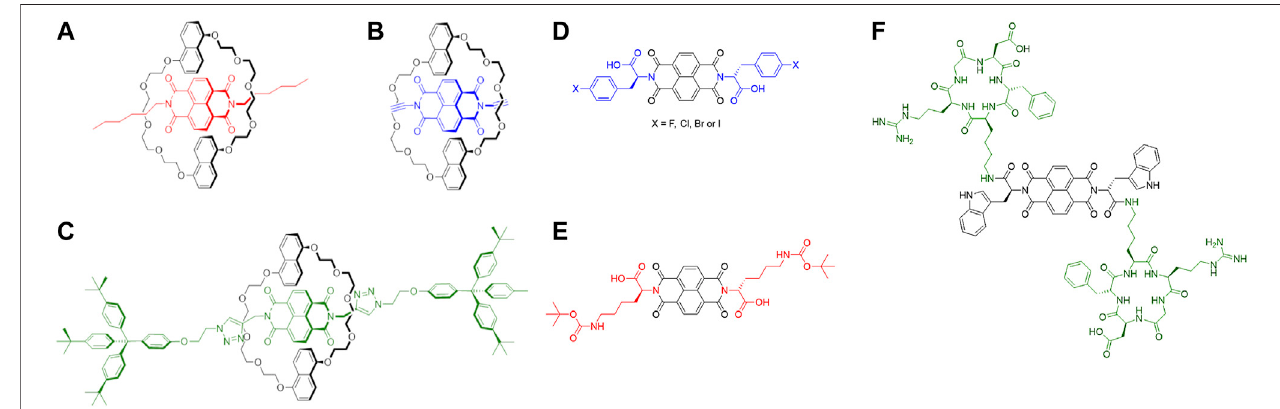
FIGURE 4 | (A – C) Examples of NDI-based rotaxanes. a) Pseudo rotaxane with alkyl chains on the NDI core as UV-visible molecular switch (Pascu et al., 2007); (B) NDI-based psuedo rotaxane intermediate for the formation of [2]-catenane (Hamilton et al., 1998); (C) NDI-based [2]rotaxane as electrochemical induced shuttle (Jacquot deRouvilleetal.,2012) (D – F) Someexamplesofaminoacid/peptide-taggedNDIs. (A) NDIcoretaggedwithhalo- L -phenylalanine(Huetal.,2012;Tysonetal., 2016)(inblue); (B) NDIcorederivatisedwith L -lysine,protectedwith tert -butoxycarbonylprotectinggroup(R ă s ă deanetal.,2017)(inred); (C) NDIcoretaggedwith cyclo (RGDfK) peptide (Hu et al., 2015) (in